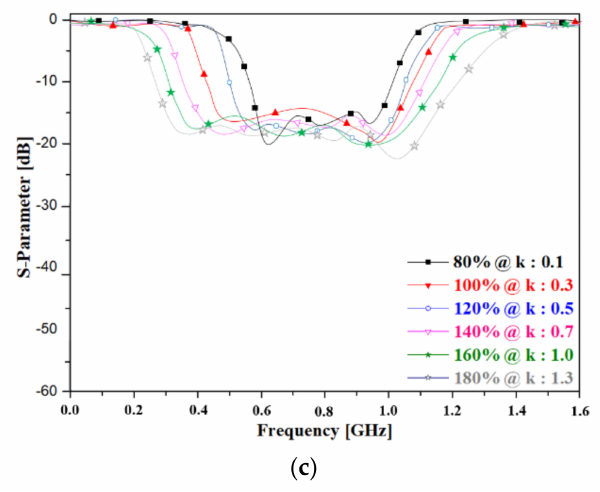
Figure 5. Variation in the FBW of the SIR structure in terms of ( a ) k -value, ( b ) parameter S 21 , and ( c ) parameter S 11